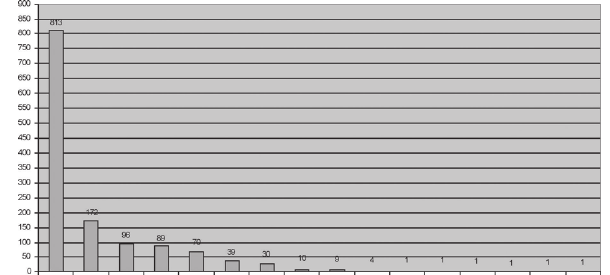
Fig. 5 - Distribuição de enxertos por